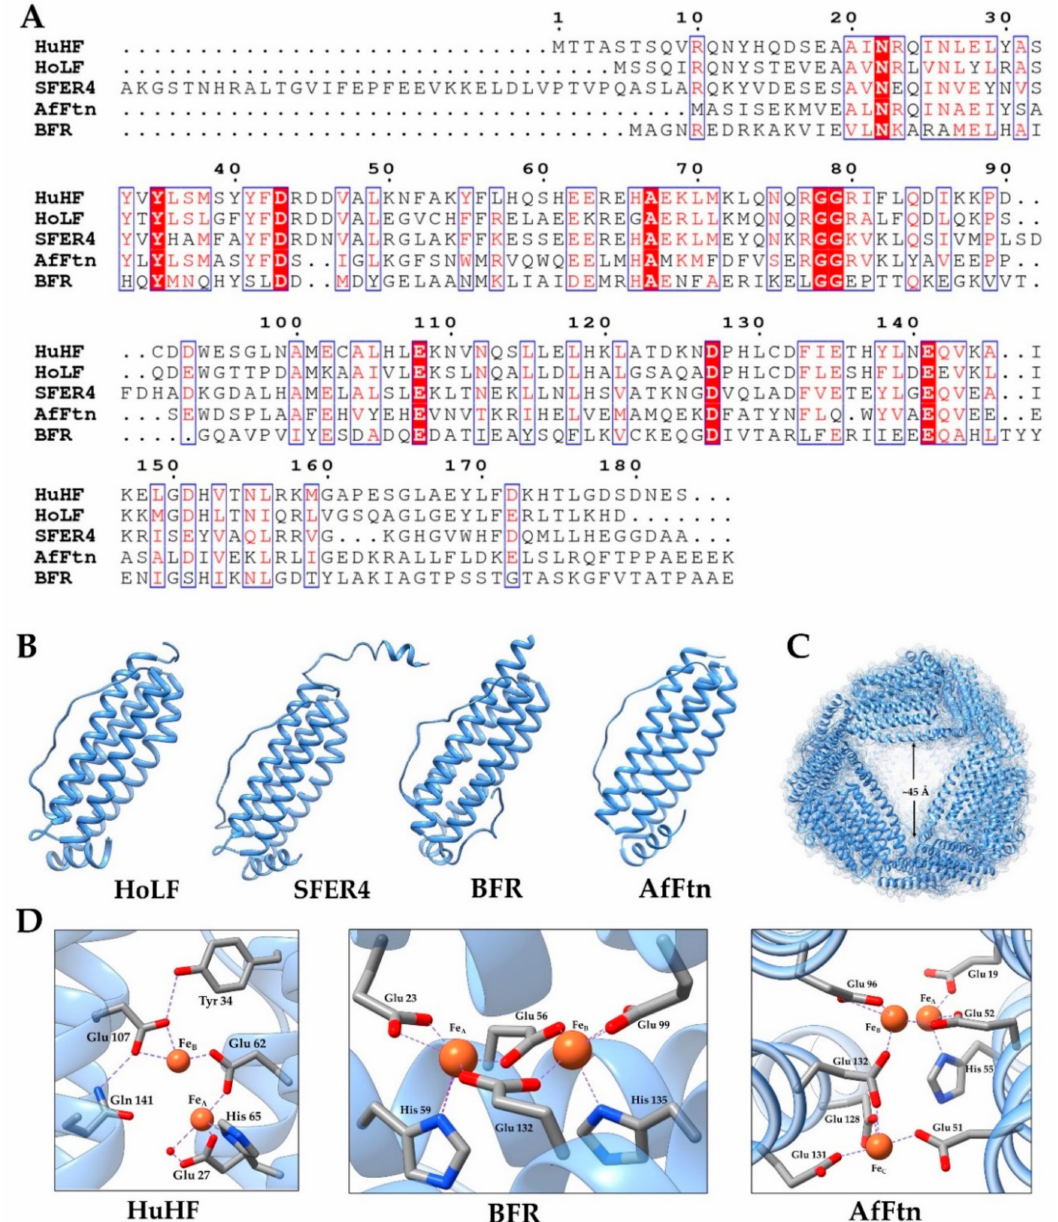
Figure 2. ( A ) Amino acid sequences of human H chain ferritin (HuHF), horse L-chain ferritin (HoLF), soybean ferritin 4 (SFER4), haem-containing bacterial ferritin (BFR), and Archaeoglobus fulgidus ferritin (AfFtn) [33]. ( B ) The subunit structure of HoLF, PDB 2v2i [34]; SFER4, PDB 3a68 [24]; BFR, PDB 1nfv [35]; and AfFtn, PDB 1s3q [36]. ( C ) The structure of AfFtn viewed down one of four large pores at a three-fold noncrystallographic symmetry axis. ( D ) The ferroxidase center of HuHF, BFR, and